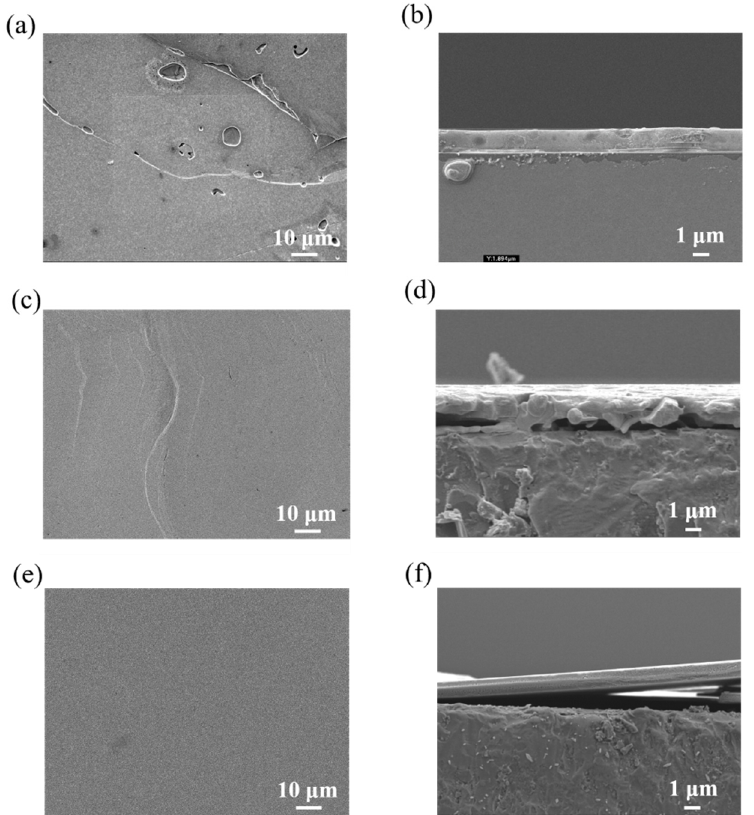
Figure 2. Surface and cross-sectional images of perovskite growth on a glass substrate 1.23 × 1.23 cm 2 in size achieved by ( a , b ) a single solvent (DMF), ( c , d ) an acetone/DMF co-solvent, and ( e , f ) an ODCB/DMF co-solvent and solution processing step.